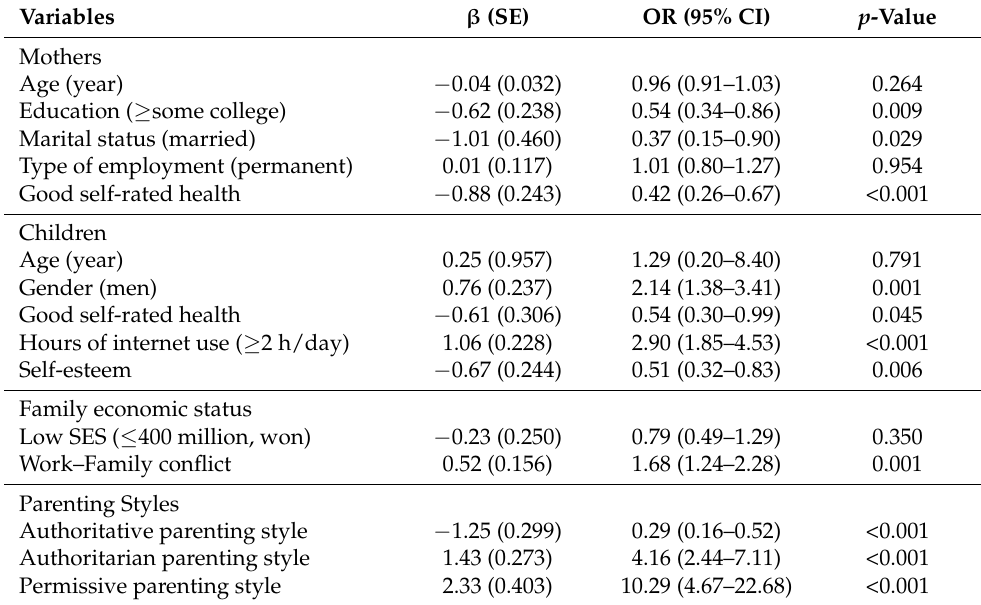
Table 2. Unadjusted associations of problematic internet use (N =